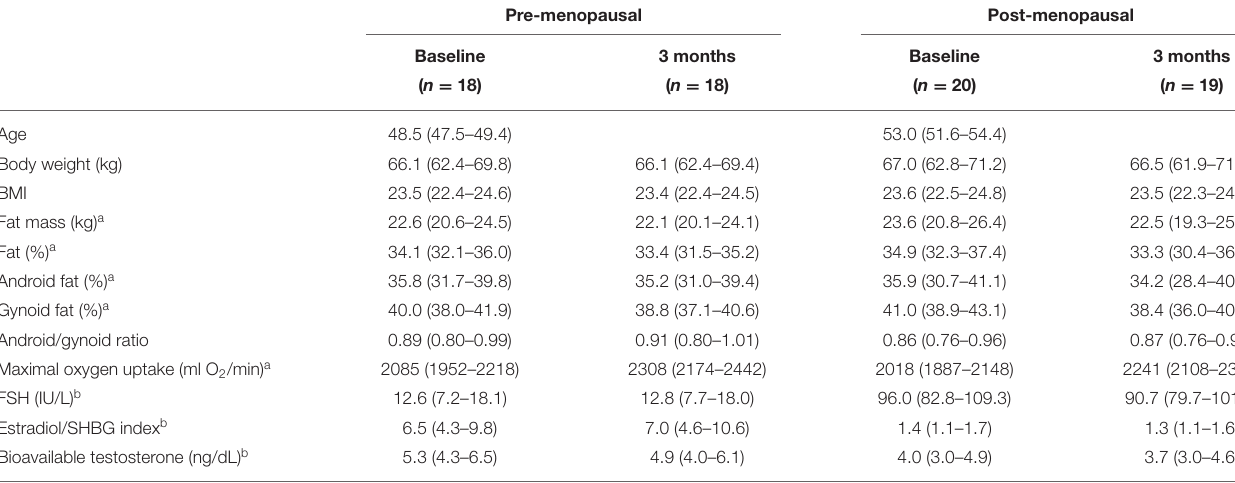
TABLE 1 | Participant characteristics of pre- and post-menopausal women before and after 3 months of high-intensity training.